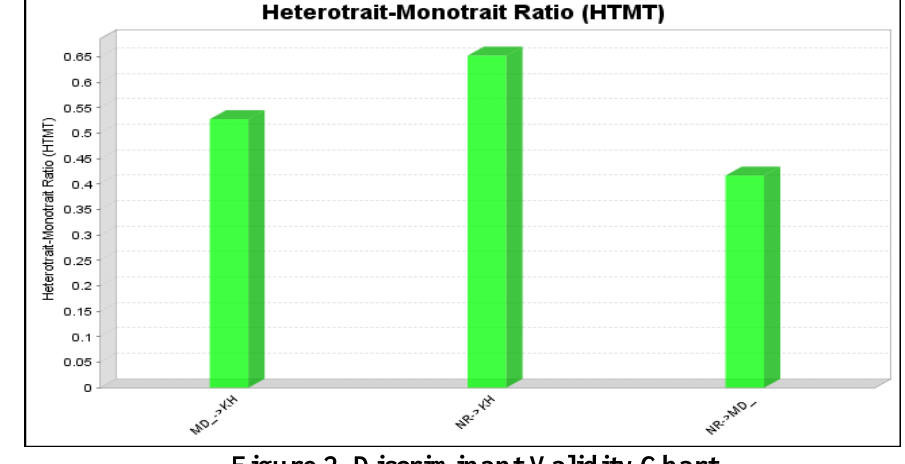
Figure.2. Discriminant Validity Chart